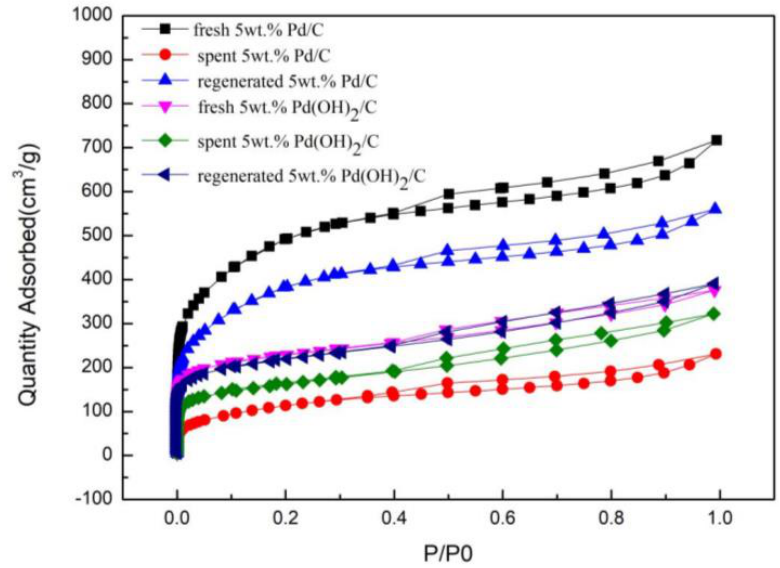
Table 4. Textural and structural properties of fresh, spent and regenerated 5 wt.% Pd/C and 5 wt.% Pd(OH) 2 /C catalyst.